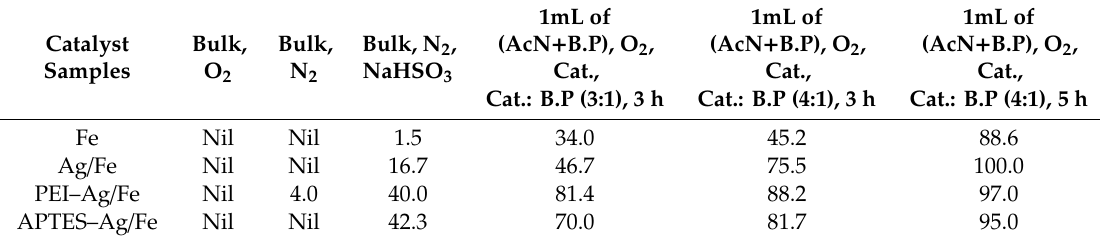
Table 1. The conversion% of PMMA using di ff erent catalyst samples at 80 ◦ C and di ff erent conditions, Bulk polymerization in O 2 andN 2 atmosphere for 5 h with and without NaHSO 3 and solution polymerization in AcN + B.P in O 2 gas with catalyst / B.P ratio = 3 / 1 and 4 / 1 after reaction times of 3 and 5